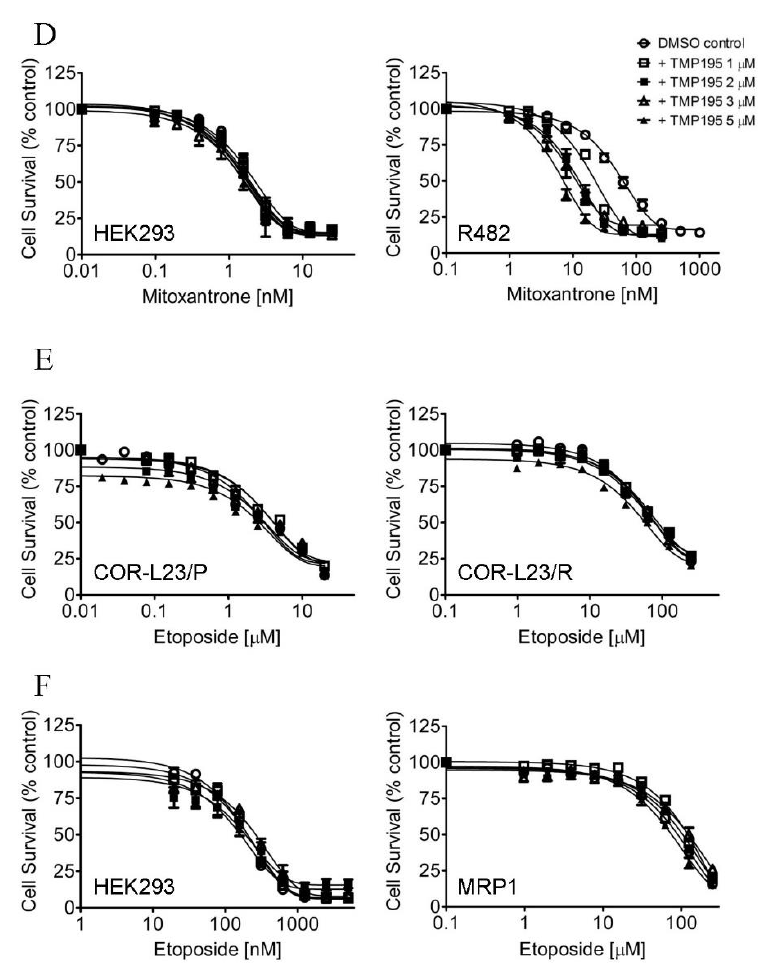
Figure 1. TMP195 re-sensitizes ABCB1-overexpressing cells to paclitaxel and ABCG2-overexpressing cells to mitoxantrone. The chemosensitization effect of TMP195 was examined by treating cells with increasing concentrations of paclitaxel (a known substrate drug of ABCB1), or mitoxantrone (a known substrate drug of ABCG2) or etoposide (a known substrate drug of ABCC1) in the presence of DMSO (open circles) or TMP195 at 1 μM (open squares), 2 μM (filled squares), 3 μM (open triangles) or 5 μM (filled triangles). ( A ) Drug-sensitive parental KB-3-1 (left panel) and the ABCB1-overexpressing multidrug resistance (MDR) variant KB-V-1 (right panel) human epidermal cancer cells, as well as ( B ) HEK293 cells (left panel) and HEK293 cells transfected with human ABCB1 (MDR1, right panel) were used to determine the effect of TMP195 on ABCB1-mediated paclitaxel resistance. ( C ) Drug-sensitive parental S1 (left panel) and the ABCG2-overexpressing MDR variant S1-M1-80 (right panel) human colon cancer cells, as well as ( D ) HEK293 cells (left panel) and HEK293 cells transfected with human ABCG2 (R482, right panel) were used to determine the effect of TMP195 on ABCG2-mediated mitoxantrone resistance. ( E ) Drug-sensitive parental COR-L23/P (left panel) and the ABCC1-overexpressing MDR variant COR-L23/R (right panel) human lung cancer cells, as well as ( F ) HEK293 cells (left panel) and HEK293 cells transfected with human ABCC1 (MRP1, right panel) were used to determine the effect of TMP195 on ABCC1-mediated etoposide resistance. Points, mean values from at least three independent experiments; error bars, SEM.